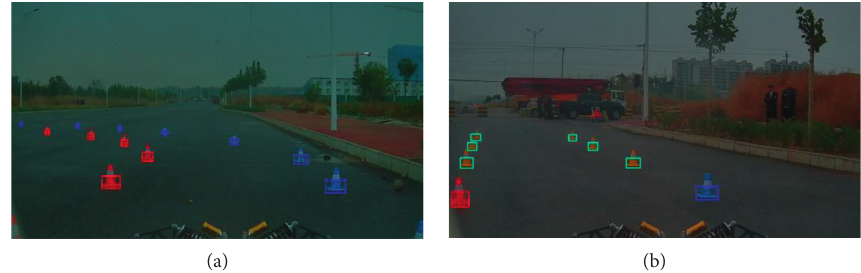
Figure 8: Road test. (a) The curve-line section. (b) The straight-line